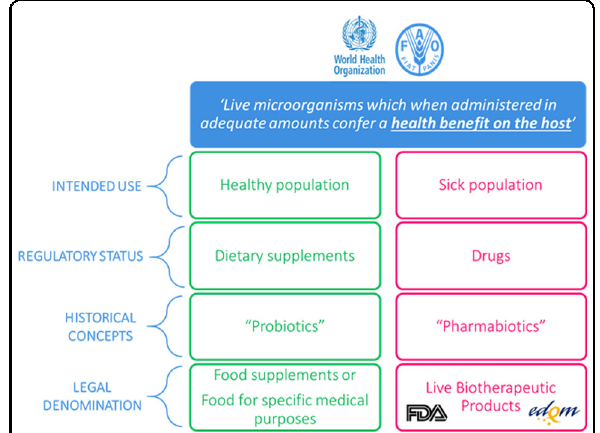
Fig. 1 Clari fi cation of the terminology and corresponding regulatory